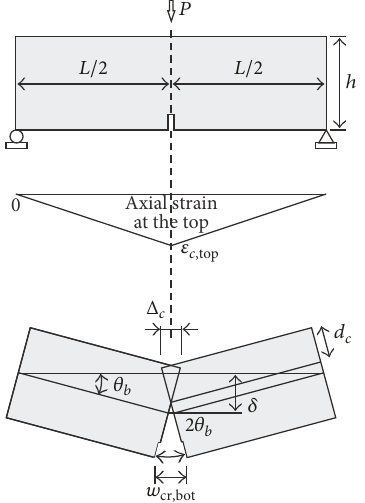
softening behavior, whereas theoretical models for higher performance fiber reinforced concrete are still limited. Figure 2: Idealized failure mode of UHPFRC beam